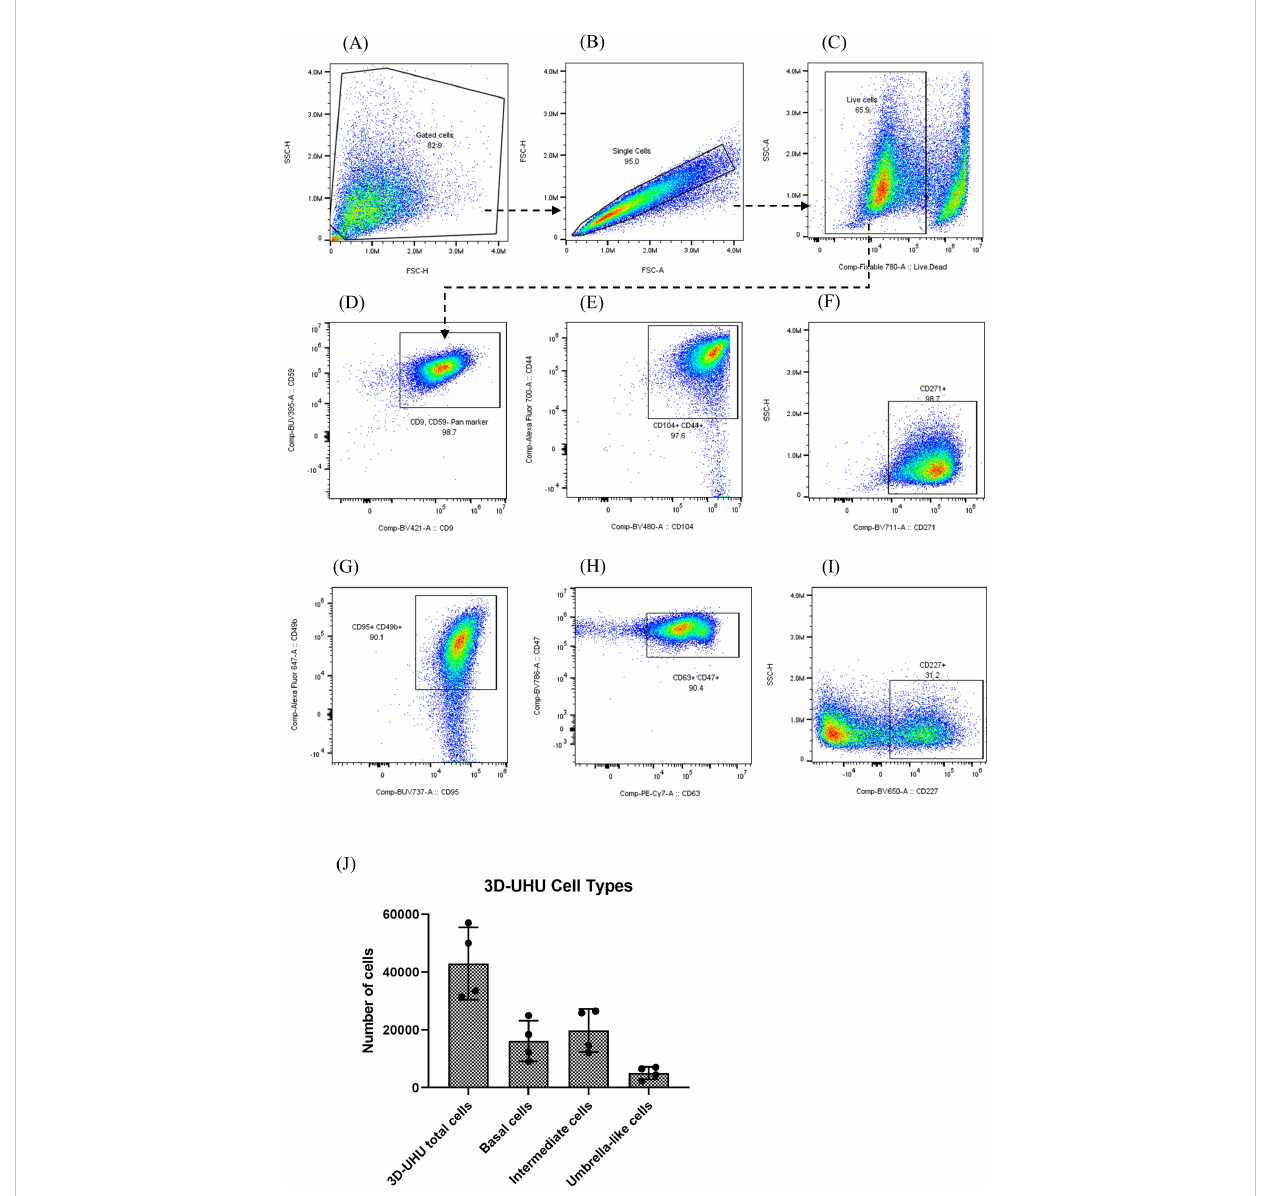
FIGURE 2 3D-UHU model expresses human bladder urothelial CD phenotypes. (A – C) gating strategy to pro fi le urothelial CD markers by fl ow cytometry; (D – I) fl ow cytometric analysis of the expression of CD9/CD59 (pan cell surface markers); CD44/CD104, CD271 (basal cells); CD95/CD49b (intermediate cells); CD63/CD47, CD227 (umbrella cells); (J) number of basal cells (CD271 + ), intermediate cells (CD95 + /CD49b + ), and umbrella-like cells (CD227 + ) in 3D-UHU model; data represent mean ± SD, n=4 biologically independent